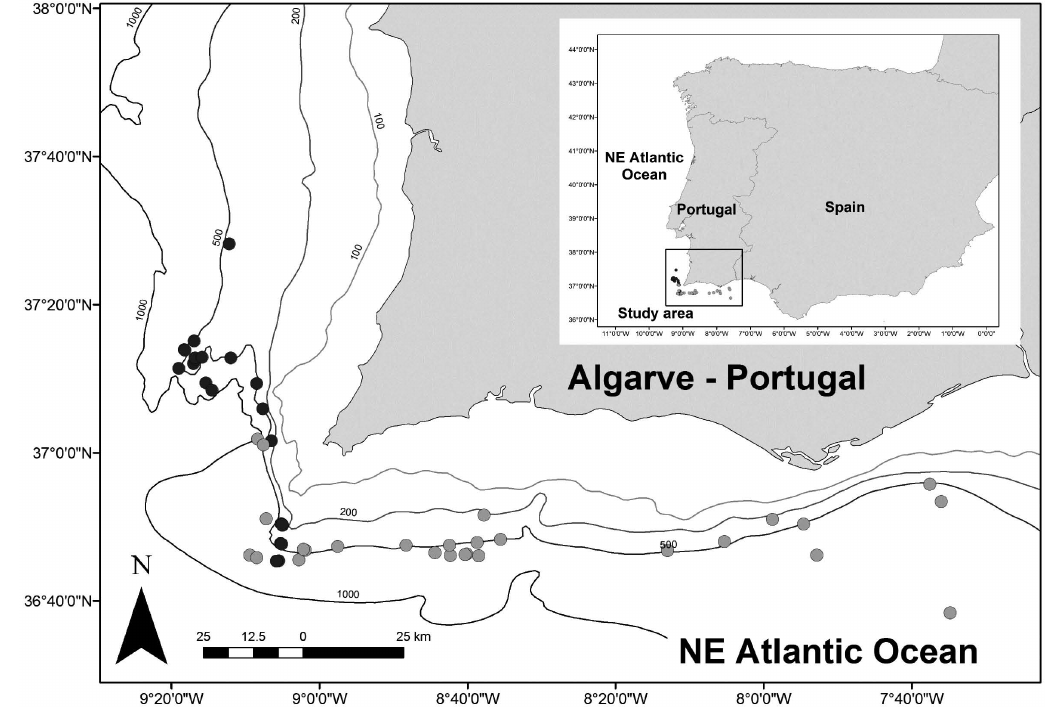
Fig . 1. – Location of the longline (black circles) and trawl (grey circles) sets that provided Etmopterus pusillus samples for this